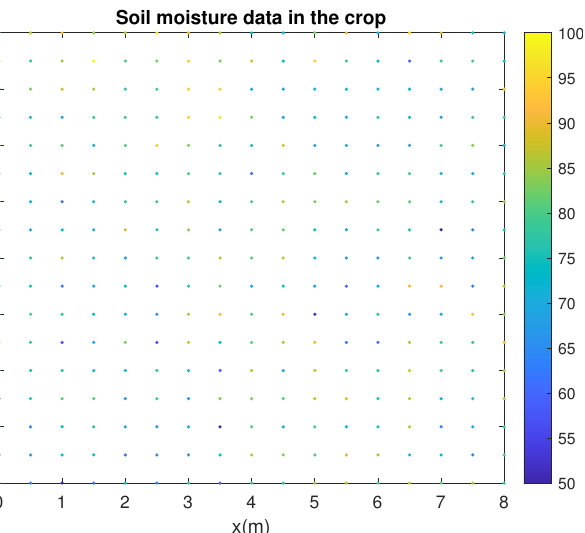
Figure 5. Two-hundred and eighty-nine measurement points within the experimental crop (8 m × 8 m) to generate the reference soil moisture